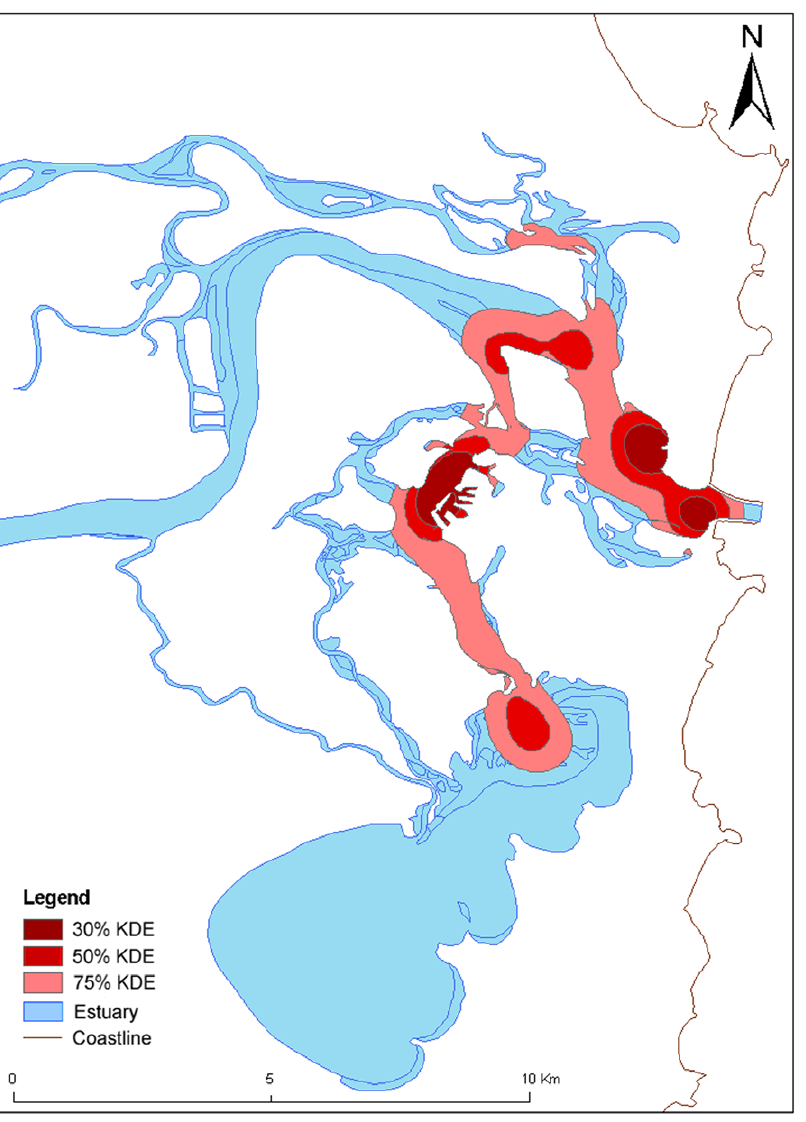
Figure 4. Female groups’ kernel density estimator (KDE) for all behaviours from the Clarence River estuary (N=539).